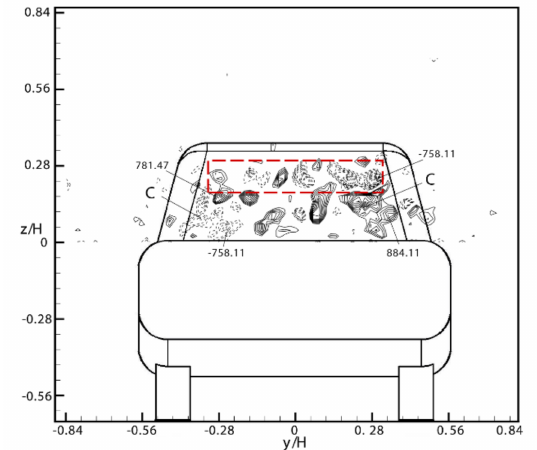
Figure 11. Iso-contours of instantaneous stream-wise vorticity, ω x in the y–z plane at x/H = − 0.39. Minimum and incremental values of vorticity are ω x,min = − 347.552 s − 1 , 370.918 s − 1 , and − 1 , ∆ ω x = 128.298 s